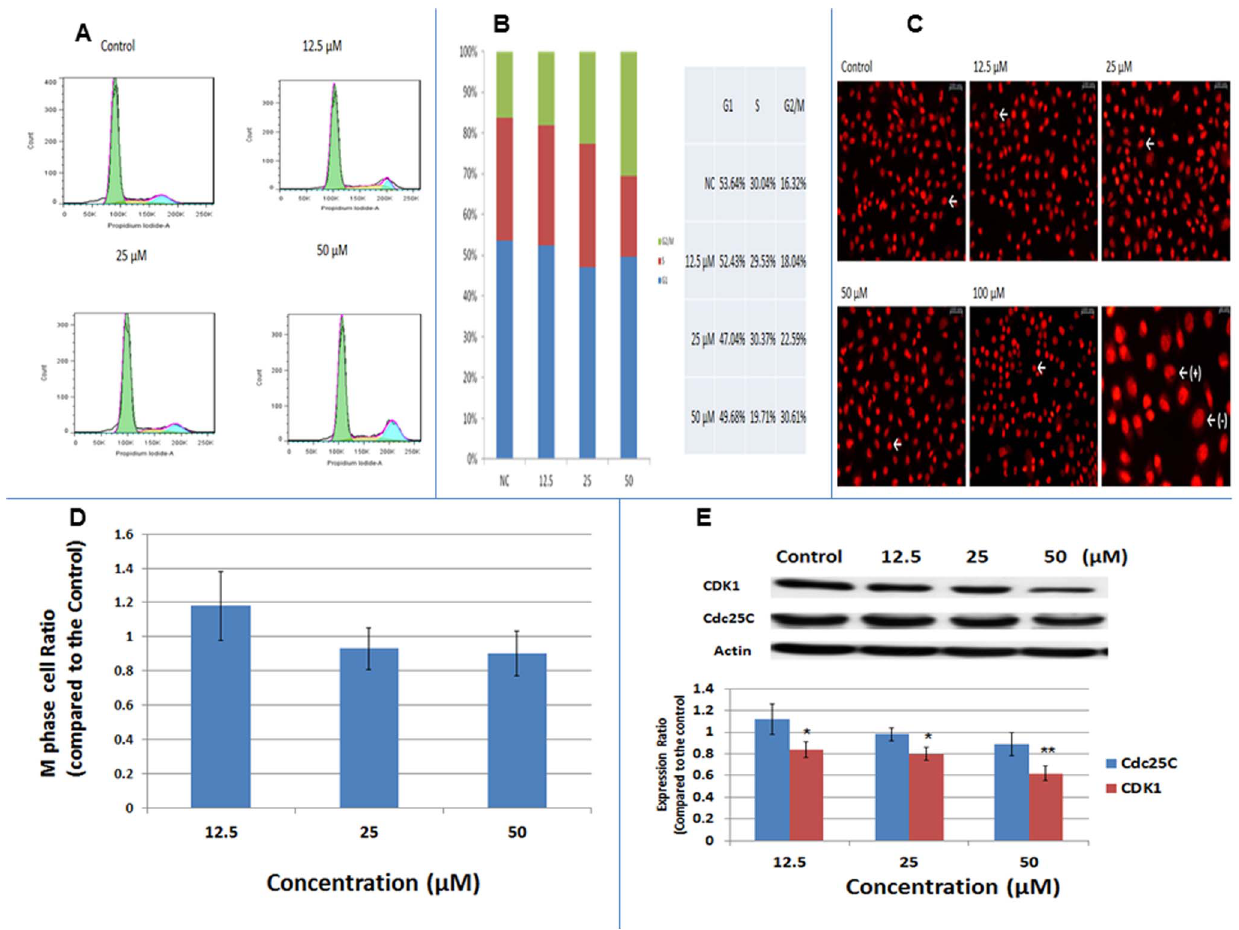
Figure 2. Celecoxib induced cell cycle arrest at the G2 phase in CGCCA cells. CGCCA cells were treated with the indicated concentration of celecoxib for 1 day, and the cell cycle distribution was analysed. (A and B) After 1 day of celecoxib treatment, CGCCA cells were analysed by flow cytometry to determine cell cycle distribution. (C) Treated CGCCA cells were stained with PI to show condensed chromatin (white arrow) in M-phase cells. In the right lower panel, the ( + ) and (–) are examples of cells with and without condensed chromatin, respectively. (D) Ratio of CGCCA cells at M- phase. (E) Expression levels of Cdc25C and CDK1 in CGCCA cells after 1 day of treatment with the indicated concentrations of celecoxib as measured using western blot. Results are presented as % of the control. Each value is a mean 6 SD of 3 to 5 determinations. *p , 0.05, **p , 0.001 (versus control).